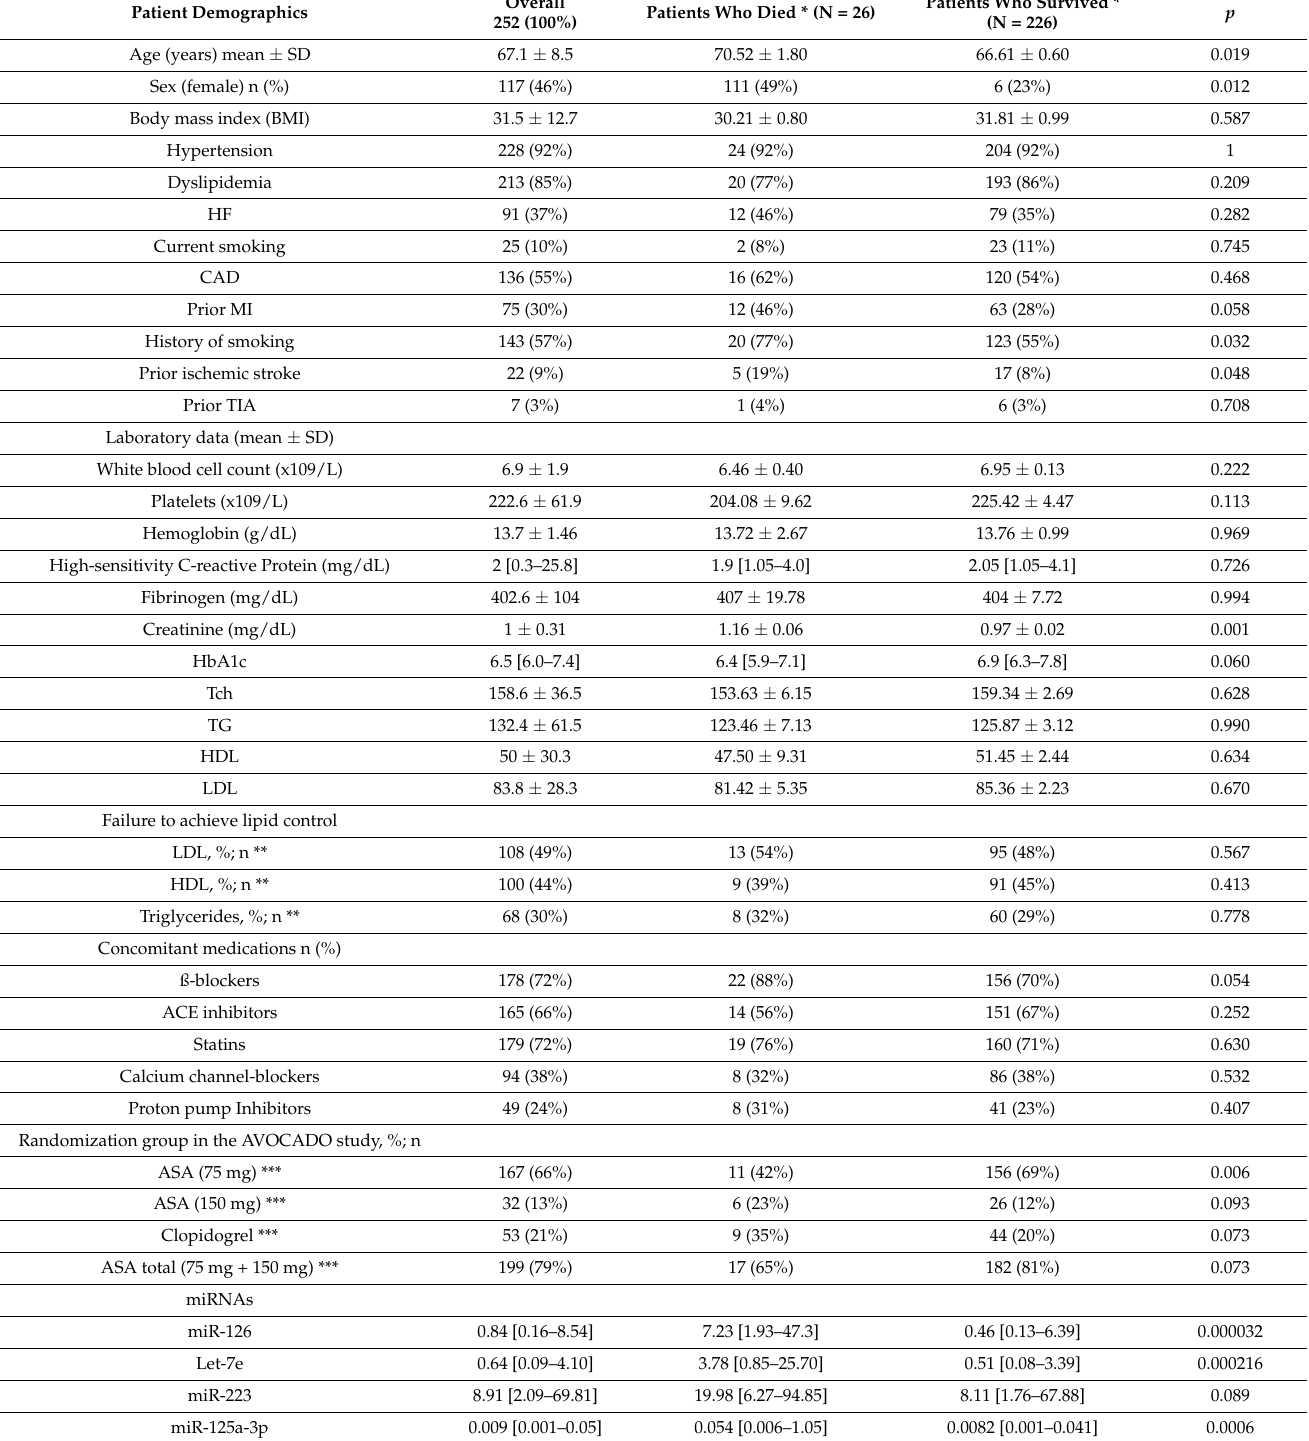
Table 1. Demographic and clinical characteristics of the study